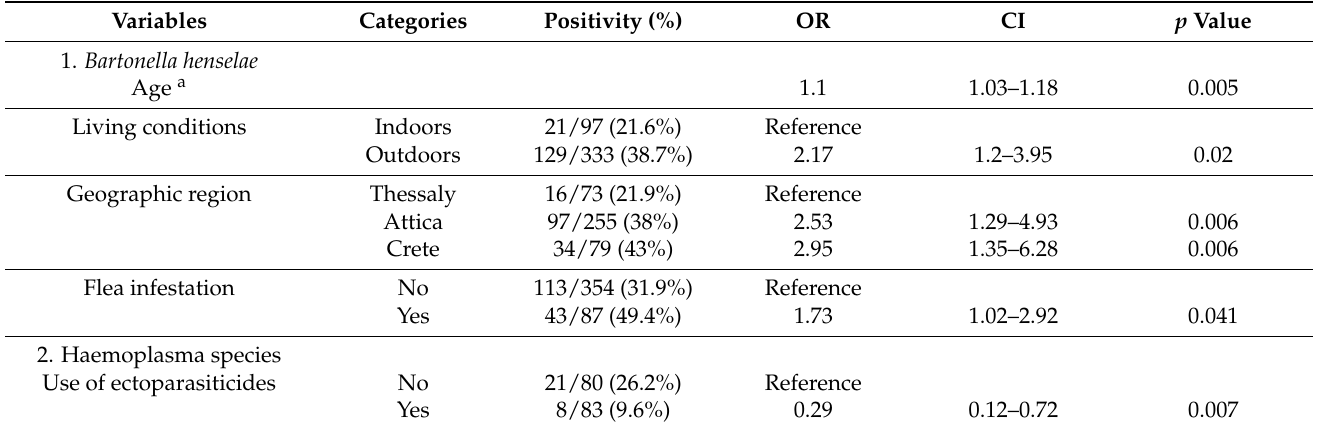
Table 3. Multivariate analysis of signalment and historical data identified as factors associated